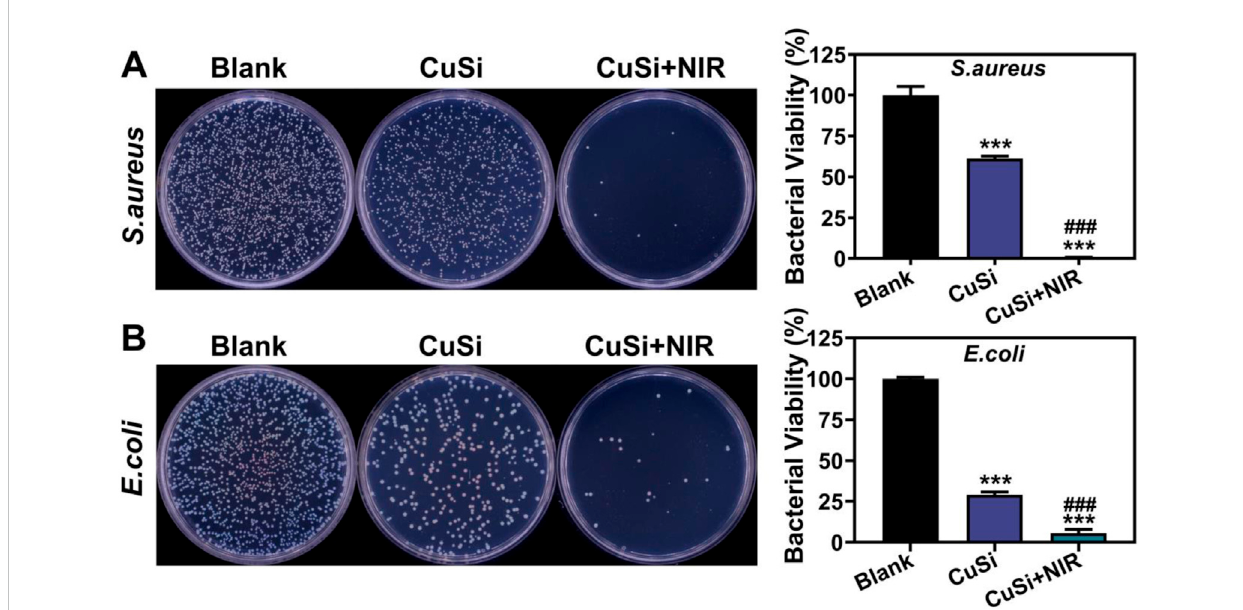
FIGURE 5 Antibacterial activityofCuSi NWsagainst S.aureus and E. coli . (A) Representative photos andbacterialviability percentage of S.aureus withdifferent treatments( n =3). (B) Representativephotosandbacterialviabilitypercentageof E.coli withdifferenttreatments( n